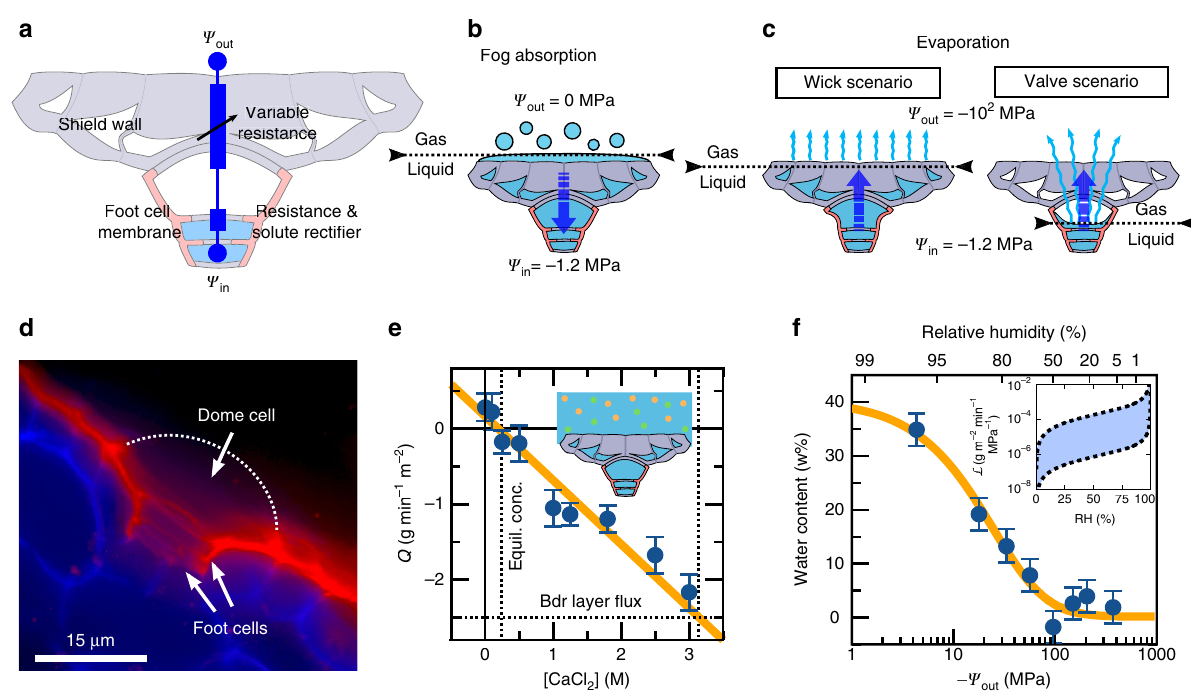
Fig. 3 Conducting elements of the Tillandsia trichome valve. a Equivalent electrical circuit for the Tillandsia trichome with the three elements contributing to fl ow asymmetry. b Flow of water during fog absorption. c Flow of water during evaporation under two distinct scenarios. d Thin cuticle layer lining the lateral walls of the dome cell and trichome stalk (red). The outer uncutinized wall of the dome cell is shown with a dotted line. e Water fl uxes for T. aeranthos leaves exposed to CaCl n > 10). At a critical concentration of 0.24 M (dotted line), the fl ow of water changes 2 solutions (mean ± relative error, direction. In contrast, a concentration of 3 M is needed to maintain a liquid water fl ux equal to the boundary layer fl ux at the trichome surface. The slope is proportional to the plasma membrane conductance (see Supplementary Note 1). f Water sorption curve for isolated shield walls as a function of the atmospheric water potential and associated predicted cellulose conductance (mean ± relative error, n > 10). Inset: conductance as a function of relative humidity, see Supplementary Note